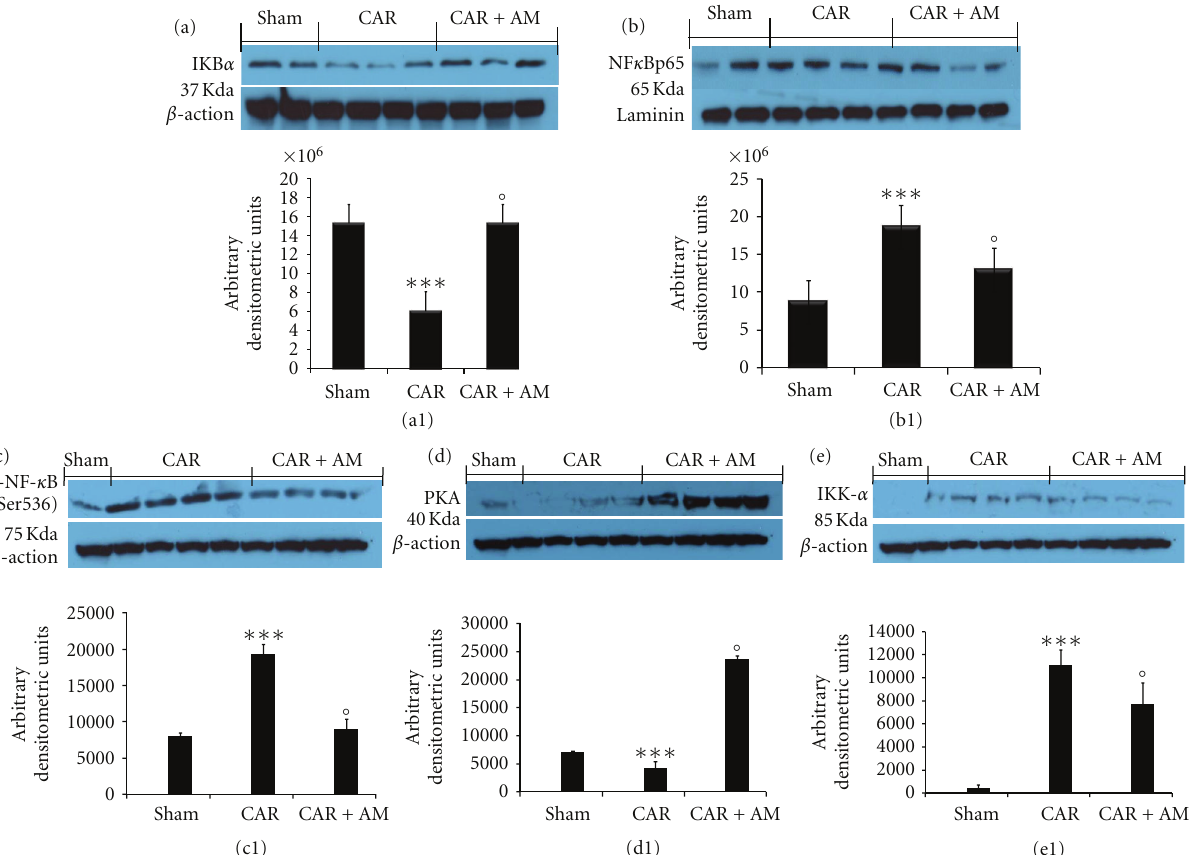
Figure 6: E ff ect of adrenomedullin (AM) on I κ B- α degradation, nuclear NF- κ B p65 quantification, IKK- α , PKA, and phospho-NF- κ B (ser536). Basal level of I κ B- α was detected in lung samples from sham-treated animals, whereas I κ B- α levels were substantially reduced in lung tissues obtained from vehicle-treated animals at 4h after CAR injection (a, a1). AM treatment prevented CAR-induced I κ B- α degradation (a, a1). NF- κ B p65 levels in the lung nuclear fractions were significantly increased at 4h after CAR injection compared to the sham-treated mice (b, b1). AM treatment significantly reduced the levels of NF- κ B p65 (b, b1). AM significantly reduced the levels of IKK alpha (e, e1) and the phosphorylation of p65 on Ser536 (c, c1). Whereas prevented CAR-induced PKA decreases (d, d1). A representative blot of lysates obtained from 5 animals per group is shown and densitometry analysis of all animals is reported. The results in panel (a1, b1, c1, d1 and e1) are expressed as mean ± s.e.m. from n = 5 / 6 lung tissues for each group. ∗ P < 0 . 01 versus sham group. ◦ P < 0 . 01 versus